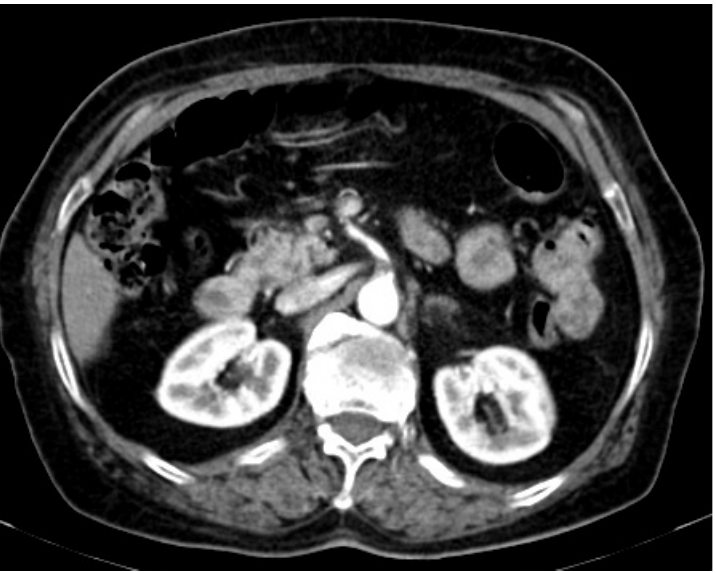
Figure 2. Abdominal CT scan revealing parietal thrombosis of the superior mesenteric artery.